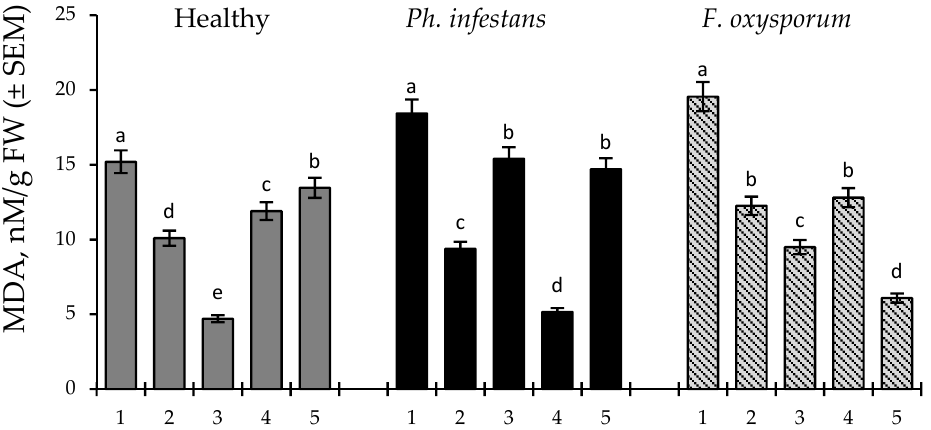
Figure 6. Effect of endophytic B. subtilis 10-4 and 26D, both individually and in compositions with SA, on MDA content in healthy and pathogens ( Ph. infestans and F. oxysporum )-infected stored potato tubers (time of storage 5 months). 1 —control (non-inoculated with B. subtilis ), 2 — B. subtilis 10-4; 3 — B. subtilis 10-4 + SA; 4 — B. subtilis 26D; 5 — B. subtilis 26D + SA. The bars are the means of three repetitions ± SEM. Different letters indicate a significant difference between the means at the probability level of p < 0.05.